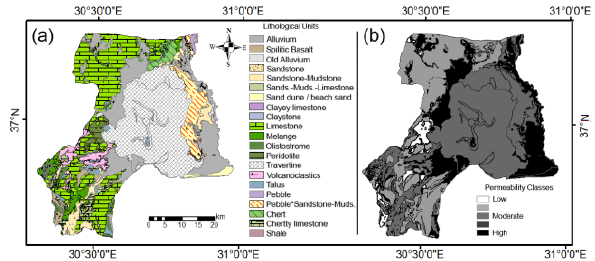
Figure 2. Classified lithological units according to permeability 2.2 Landslide Landslide inventory data were digitized from General Directorate of Mineral Research and Exploration (MTA- Turkey). Landslides were categorized into 4 classes which are based on the Varnes (1978) classification. According to this data, landslides classifies as fall, slide and flows. Most of the landslides were located on the western part of the Antalya city centre. Even though these landslide bodies are not directly fall into the study area boundary, they are very close to the study area boundary. Therefore, distance map were generated for landslide polygons. In this map, each pixel shows the distance from the landslide polygons (Figure 3). According to obtained data, the maximum distance from the landslide is computed as 33447.1 m. After generating the distance map, data were rescaled between 0 and 1. If the values are close to 1, then this area has far distance to landslide polygon(s).